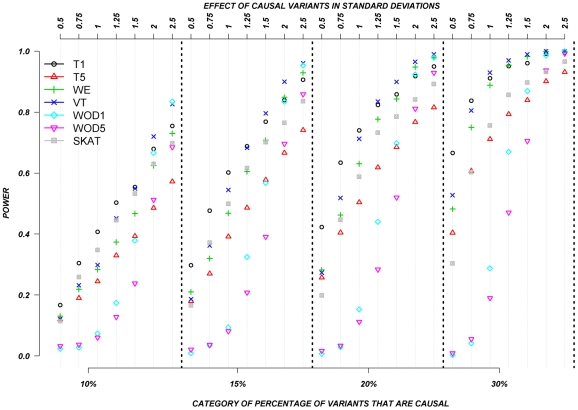
Continuous traits: Relationship between effect size, proportion of causal variants, and power.All causal variants have a deleterious effect. Each box corresponds to a different proportion of causal variants involved in the relationship between rare variants and continuous traits (from left to right, 10, 15, 20 and 30%). On the x-axis, effect sizes are in standard deviations and correspond to the absolute value of the average size effect.